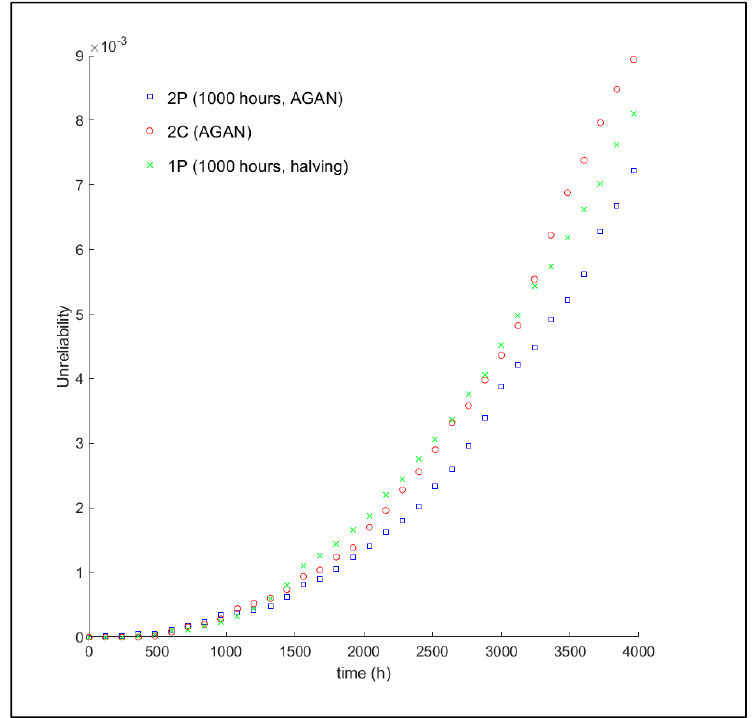
Figure 8. Steam Turbine unreliability of the SHyFTA model of Figure 7b.